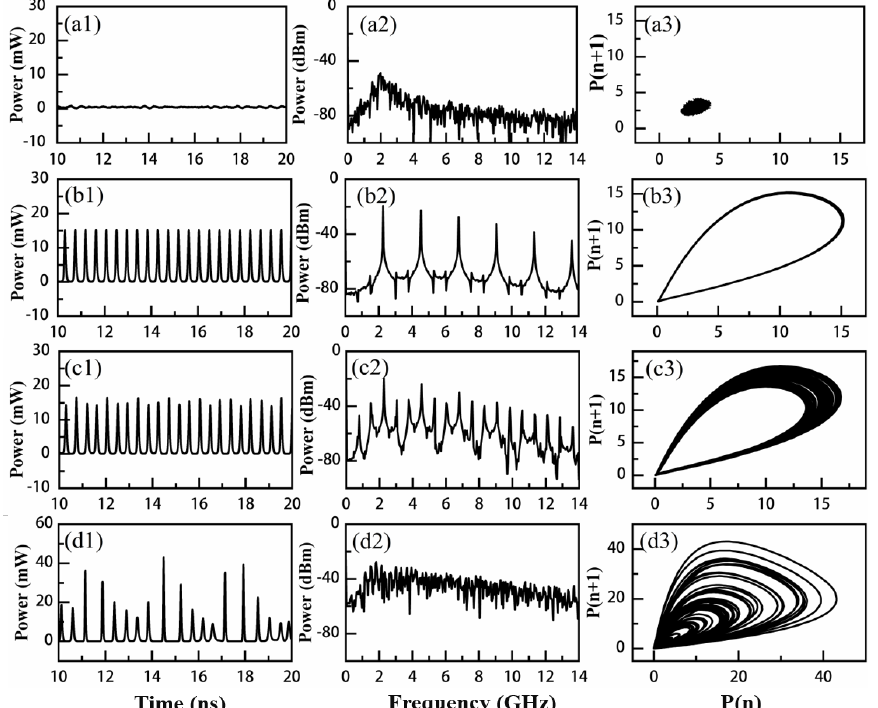
Figure 2. Time series, power spectrum, and corresponding phase portraits of dynamic states under optoelectronic filtered feedback. ( a1 – a3 ) Steady state at G = 0.4 dB; ( b1 – b3 ) Regular pulse at G = 1.5 dB; ( c1 – c3 ) Quasiperiodic state at G = 3.2 dB; ( d1 – d3 ) Chaotic pulsing at G = 5.6 dB.